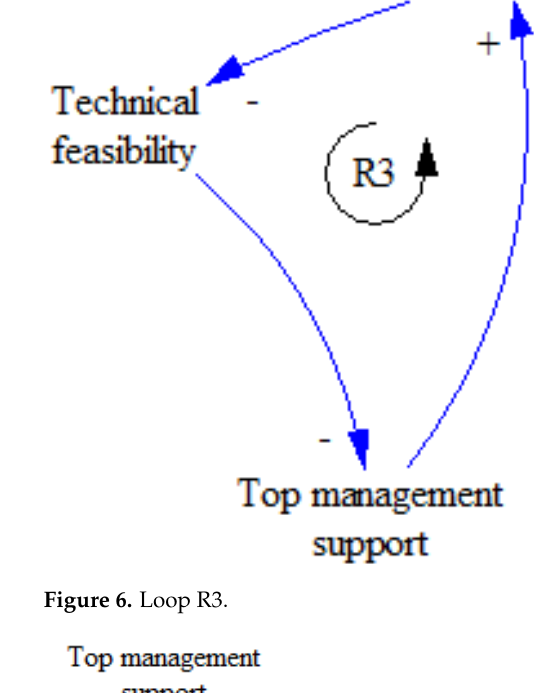
Figure 6. Loop R3.